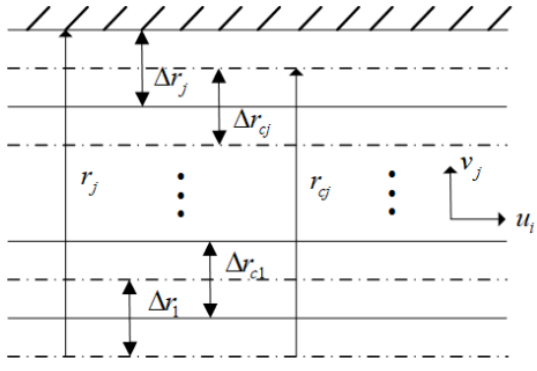
Figure 1. Radial difference grid.